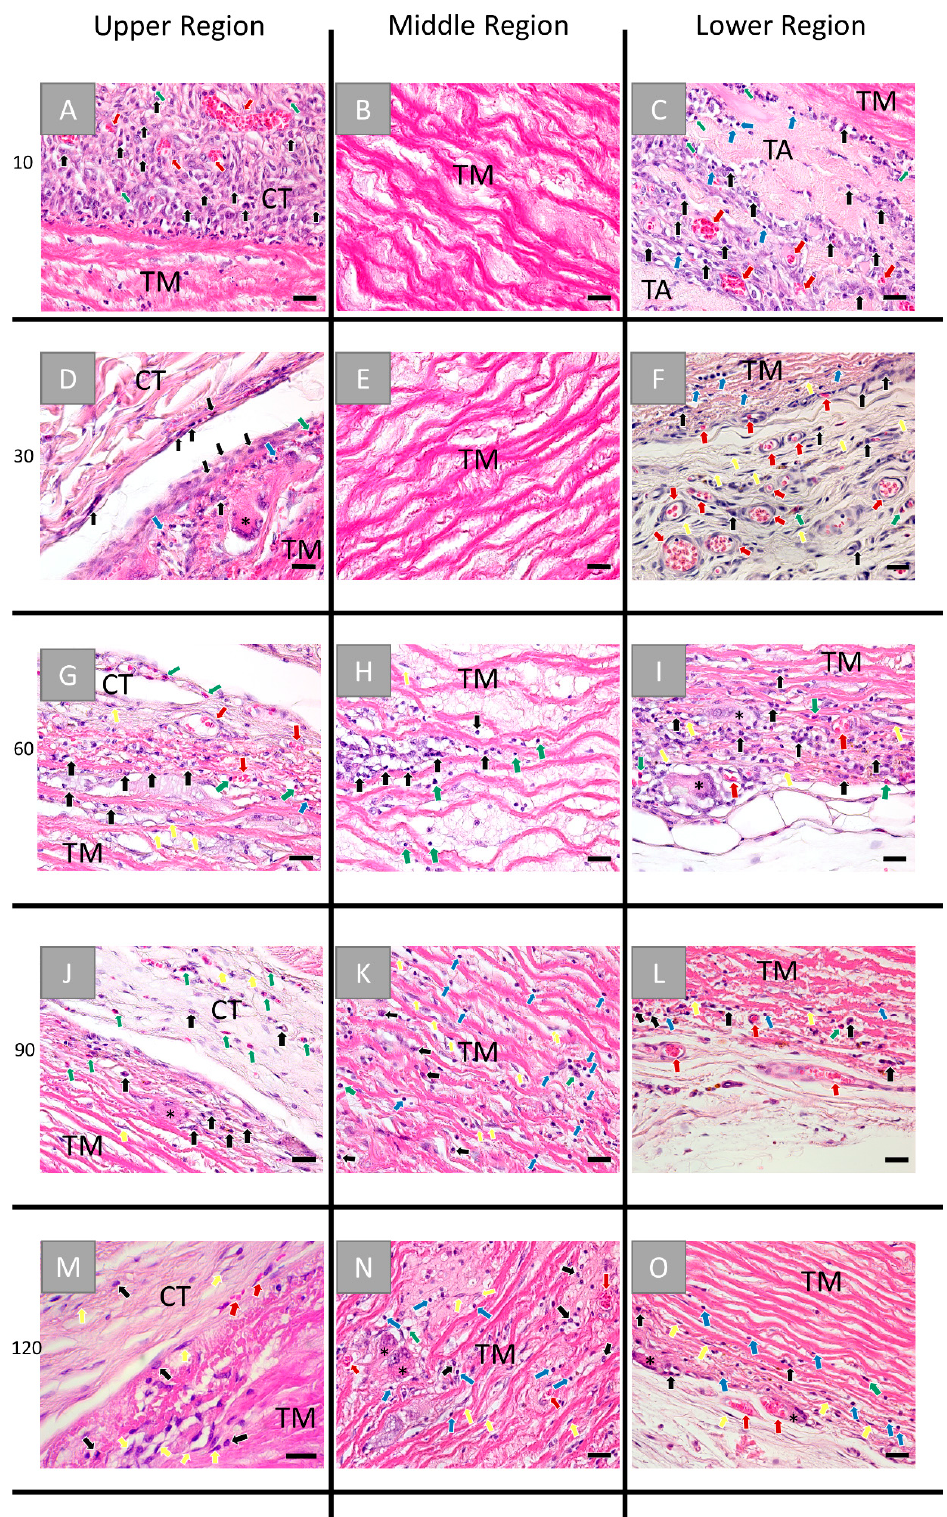
Figure 4. Histological images of the tissue reaction to the 3 different parts, i.e., the former tunica intima (left row), the tunica media (middle row), and the tunica adventitia (right row), of the porcine aorta patch after ( A – C ) 10, ( D – F ) 30, red arrows: vessels, black arrows: macrophages, blue arrows: lymphocytes, green arrows: granulocytes, yellow arrows: fibroblasts and black asterisks: multinucleated giant cells. (HE-stainings, 40 × magnification, scale bars = 20 µ